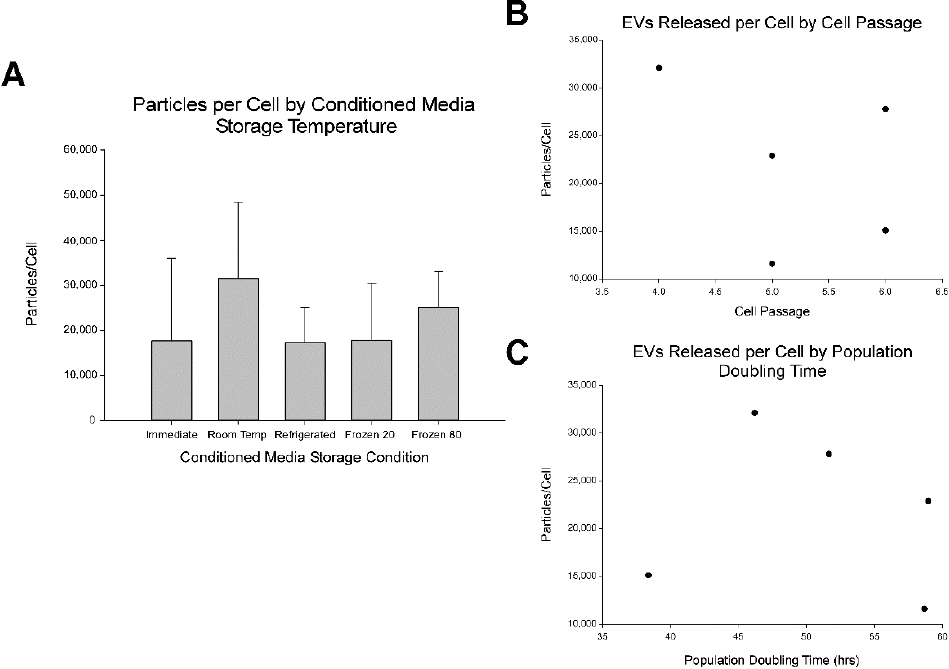
Figure 3. Pre-processing storage condition did not affect the number of EV particles recovered from human umbilical cord-derived mesenchymal stroma cells (HUC-MSCs) conditioned medium. ( A ) Number of EVs released per HUC-MSC by conditioned media (CM) pre-processing storage condition (immediate, room temperature, 4 °C, − 20 °C, and − 80 °C). EV particles released per MSC ranged from 1.73 × 10 4 ± 7.67 × 10 3 to 3.15 × 10 4 ± 1.70 × 10 4 . No significant differences were detected. Thus, CM pre-processing storage conditions had no significant impact on number of EV particles recovered. Data are presented as mean ± standard deviation and is representative of five independent cell line measurements. ( B ) Analysis of EVs particles released per MSC versus cell passage. No trends were observed. ( C ) Analysis of EVs released per cell by population doubling time. No trends were observed.